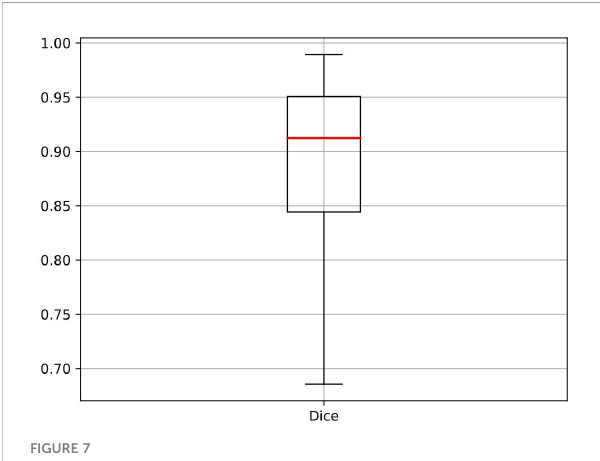
FIGURE 7 The boxplot of the Dice coef fi cients for quantitative evaluation of the automatically segmented nodules by the AI system in comparison to radiologists ’ segmentations. AI, arti fi cial intelligence.